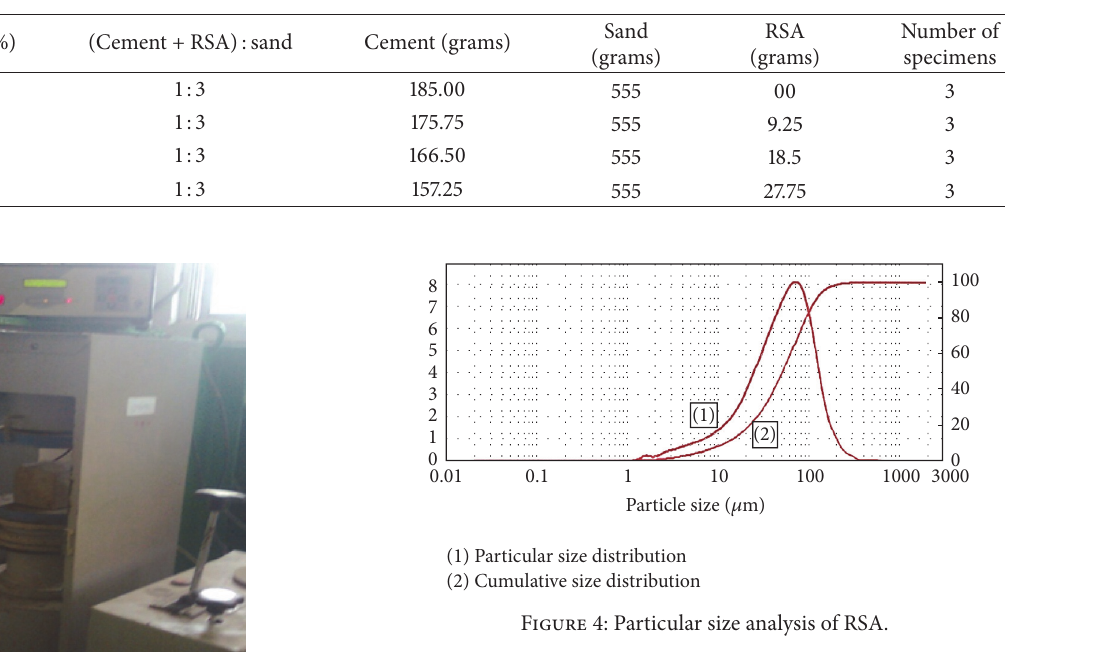
Table 3: Mix proportion by weight used in making mortar specimens.